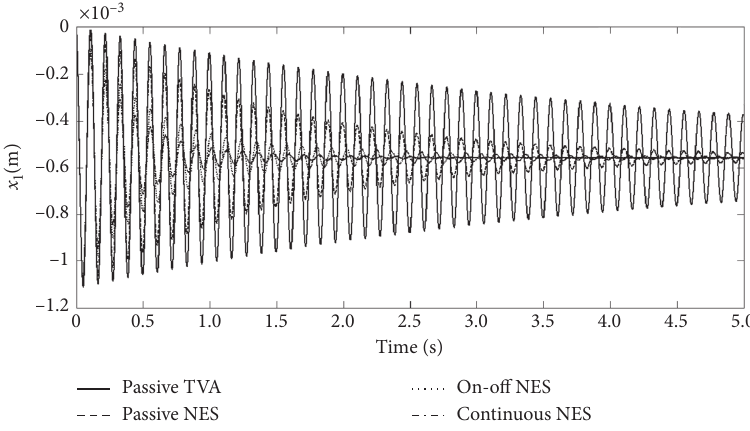
) versus k and c . (a) Global plot. (b) Local plot. 1 TVA TVA